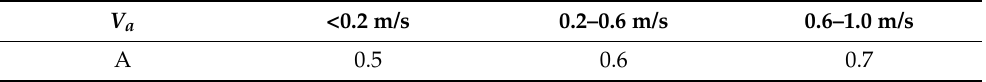
Table 5. Relationship between A and Va